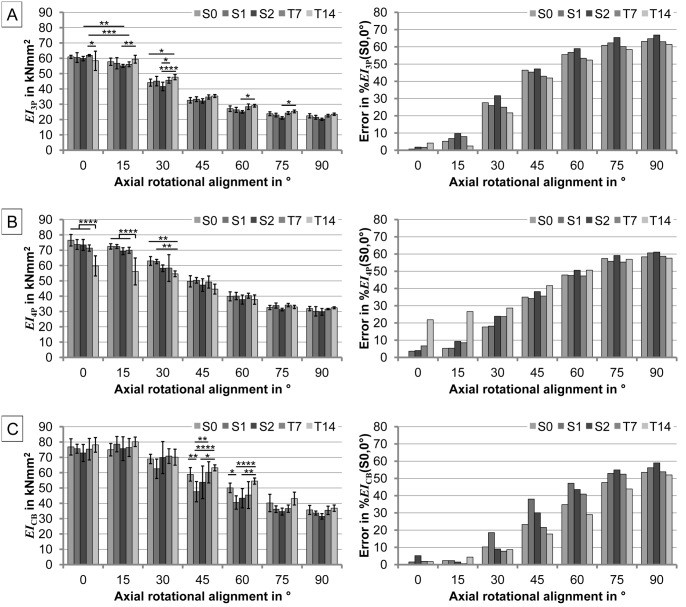
Results for the bending stiffness (mean±SD) (left) and the respective errors of the means (right) in relation to the reference mean value (i.e. respective mean stiffness of S0 at 0° axial rotational alignment) for three different bending experiments: A) Three-point bending stiffness EI
3P, B) four-point bending stiffness EI
4P, and C) cantilever bending stiffness EI
CB.Results are shown for the five different model designs (S0, S1, S2, T7, and T14) and for the seven different axial rotational angular alignments (0°-90° in 15° increments). *p<0.05, **p<0.01, ***p<0.001, ****p<0.0001.